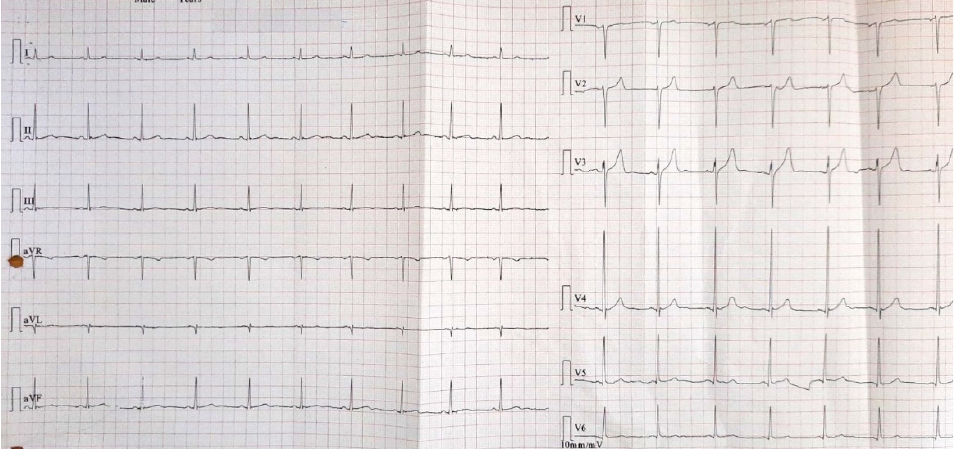
Figure 2. Resting standard ECG: sinus rhythm, normal QRS axis, ventricular rate 70 bpm, Q wave in aVL, and without any ST-segment or T-wave abnormalities.